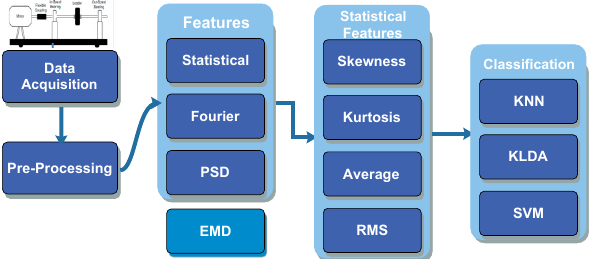
Figure 1. Block Diagram of Proposed Procedure.